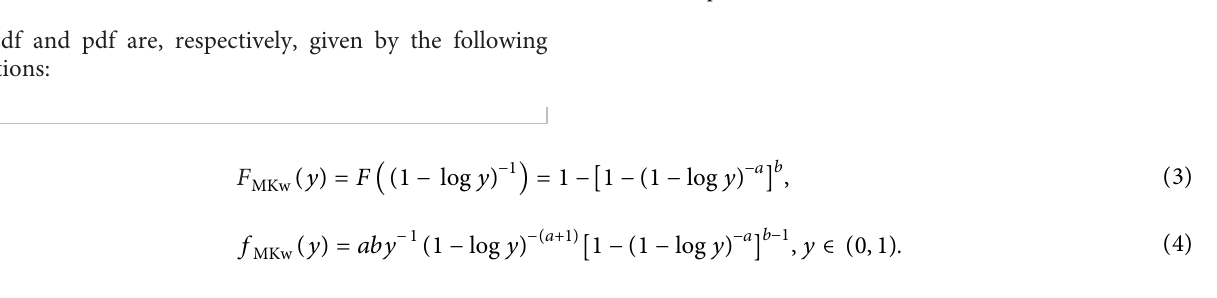
Figure 2: Plots of MKw hrf for some diferent parametric